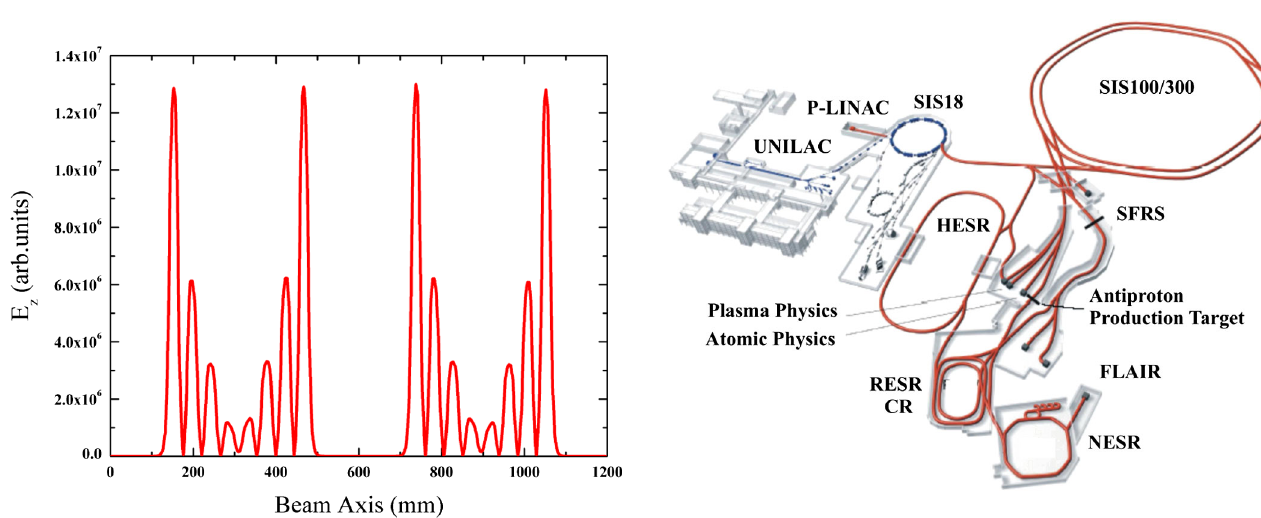
FIG. 26. The electric field distribution for the (cid:3)= 2 mode.